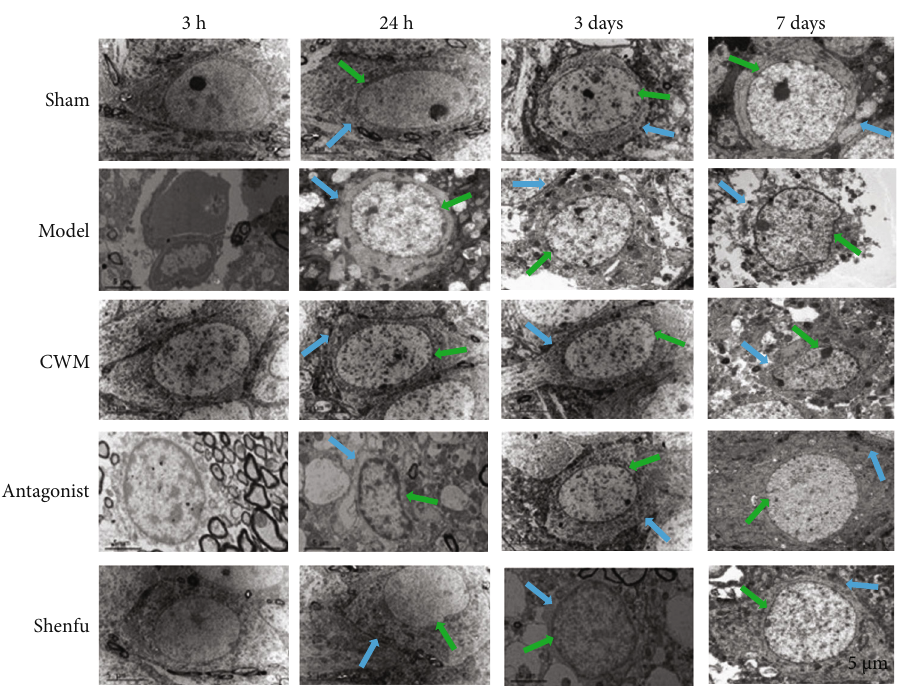
Figure 2: Ultrastructural changes of hippocampal tissue under electron microscopy. Green arrows mean cell membrane of neuron. Blue arrows mean